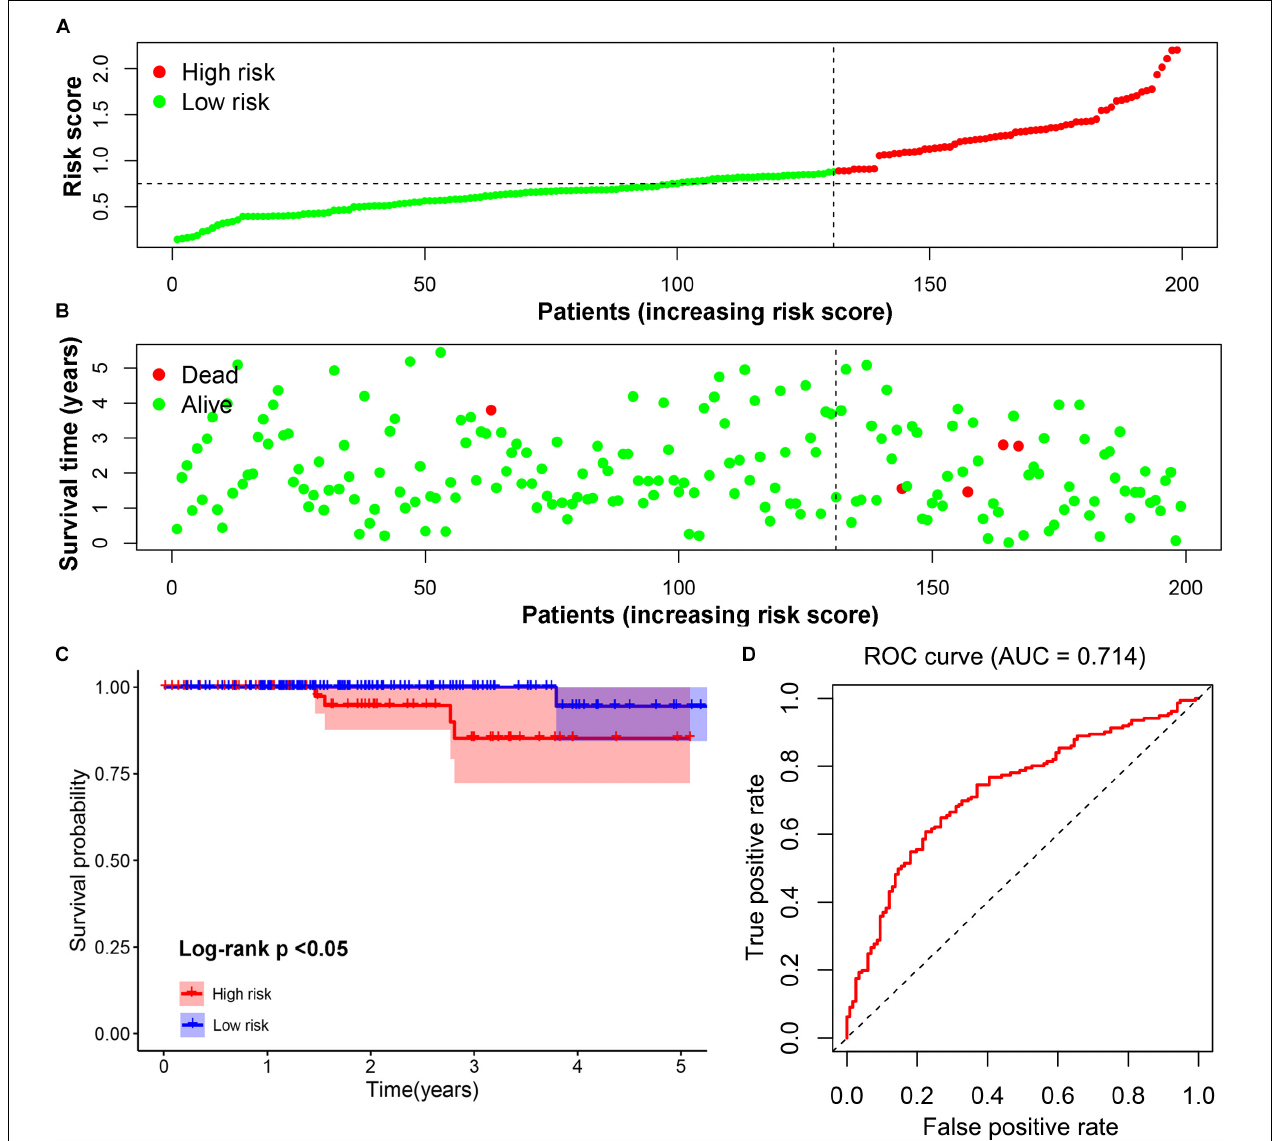
FIGURE 8 | Validation of the prognostic risk signature. (A,B) The distributions of prognostic signature-based risk scores. The red dots represent high-risk patients while green dots represent low-risk patients. (C) The survival analysis of the two subgroups. (D) The ROC curve for evaluating the prediction efficiency of the prognostic